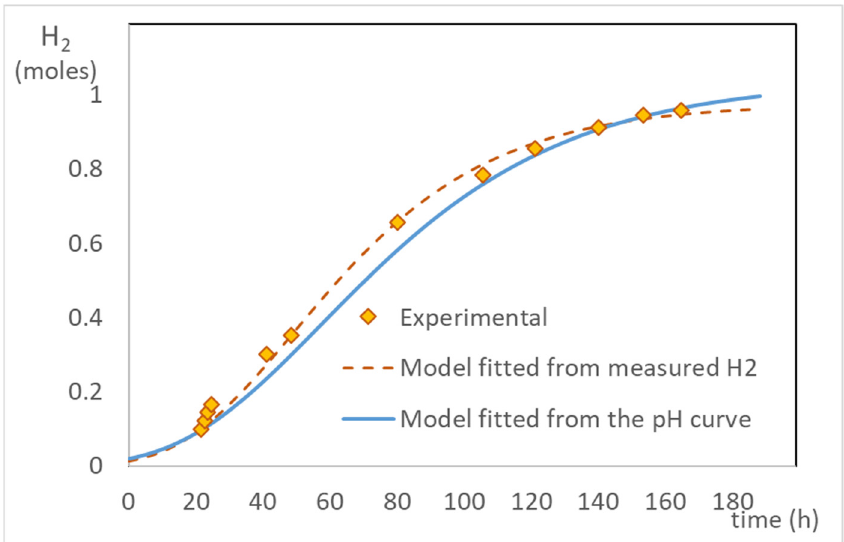
Figure 7. Comparison of experimentally measured moles of H 2 vs. the values predicted by the modified Gompertz model using parameters fitted from the experiments and the pH curve using the function f H and the relation given by Equation (13).